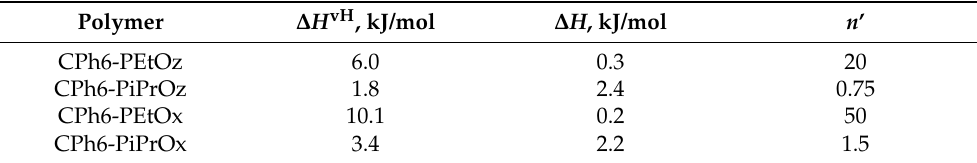
Table 2. Thermodynamic characteristics of solutions of star-shaped pseudo-polypeptoids. Polymer